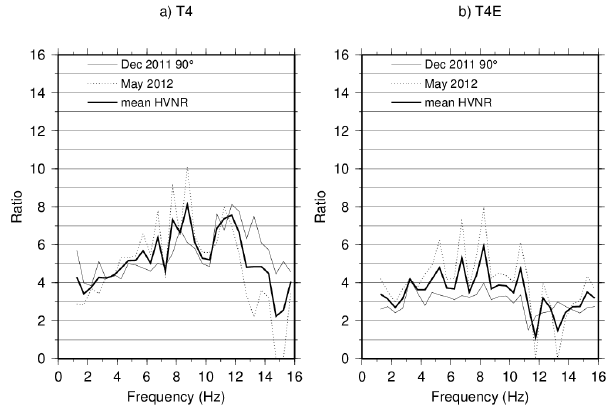
Fig. 12 - Mean values of H/V peaks oriented due N90° resulting from noise measurements at sites 2 Fig. 12. Mean values of H/V peaks oriented due 90 ◦ N resulting T4 (a) and T4E (b), on the rim of the megabreccia scarp; thick solid line represents the average of 3 from noise measurements at sites T4 (a) and T4E (b) , on the rim noise H/V peak values derived from different measurements. 4 of the megabreccia scarp; thick solid line represents the average of noise H/V peak values derived from different